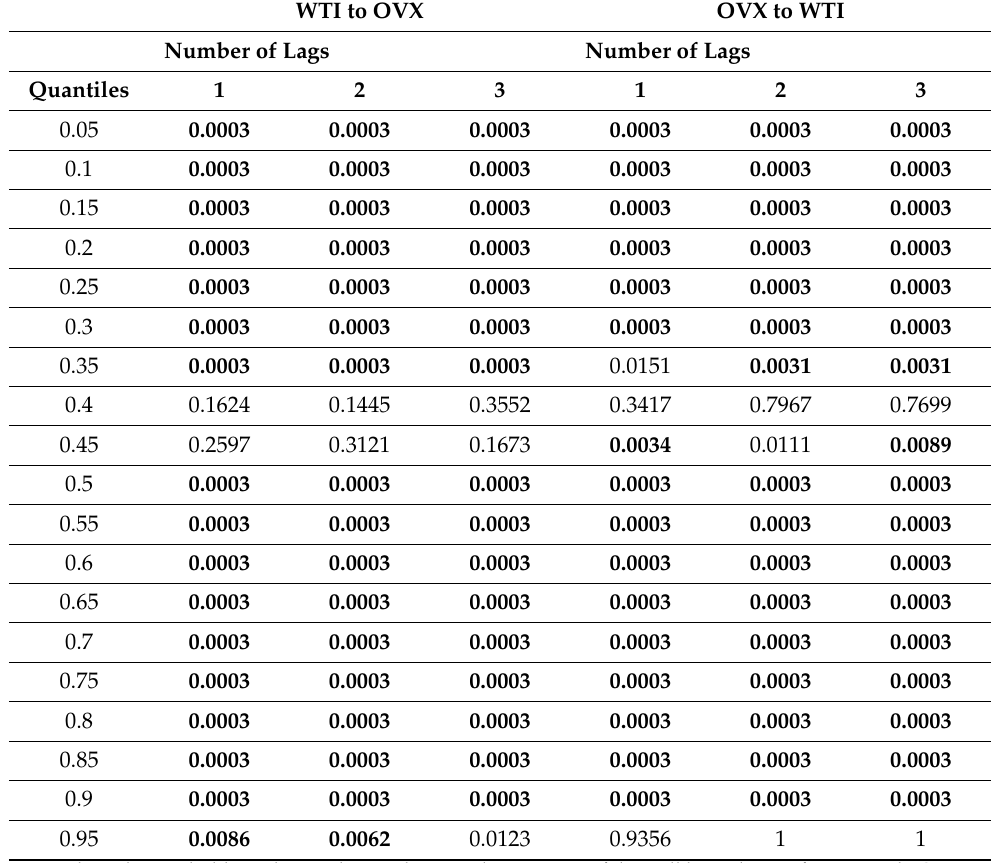
Table 7. Granger causality in quantiles: subsample p